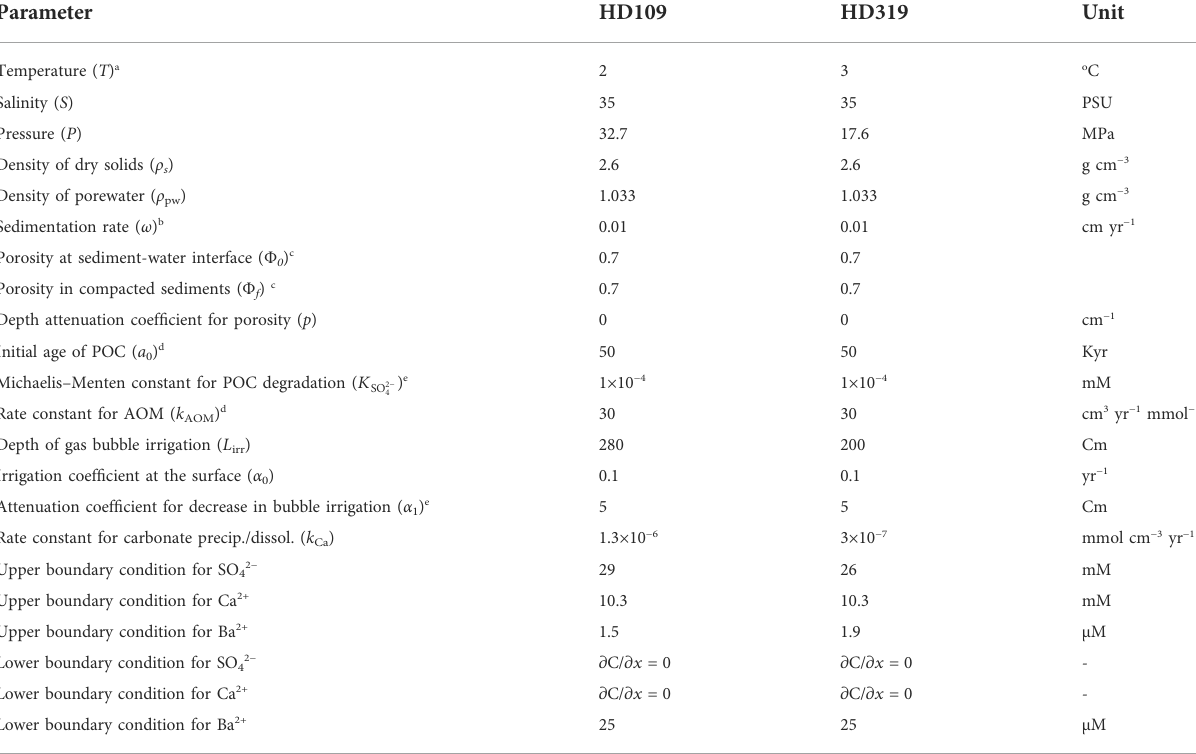
TABLE 4 The dataset of speci fi c parameters and boundary conditions used in the